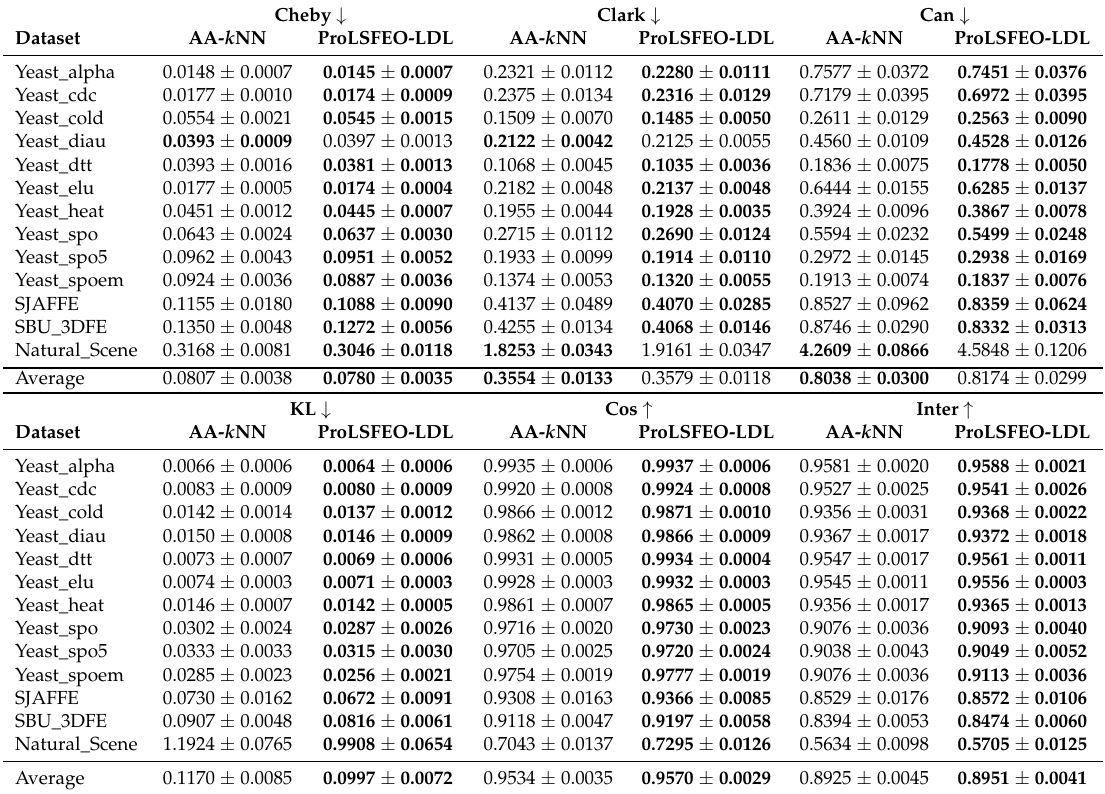
Table 4. Experimental Results (mean ± std).